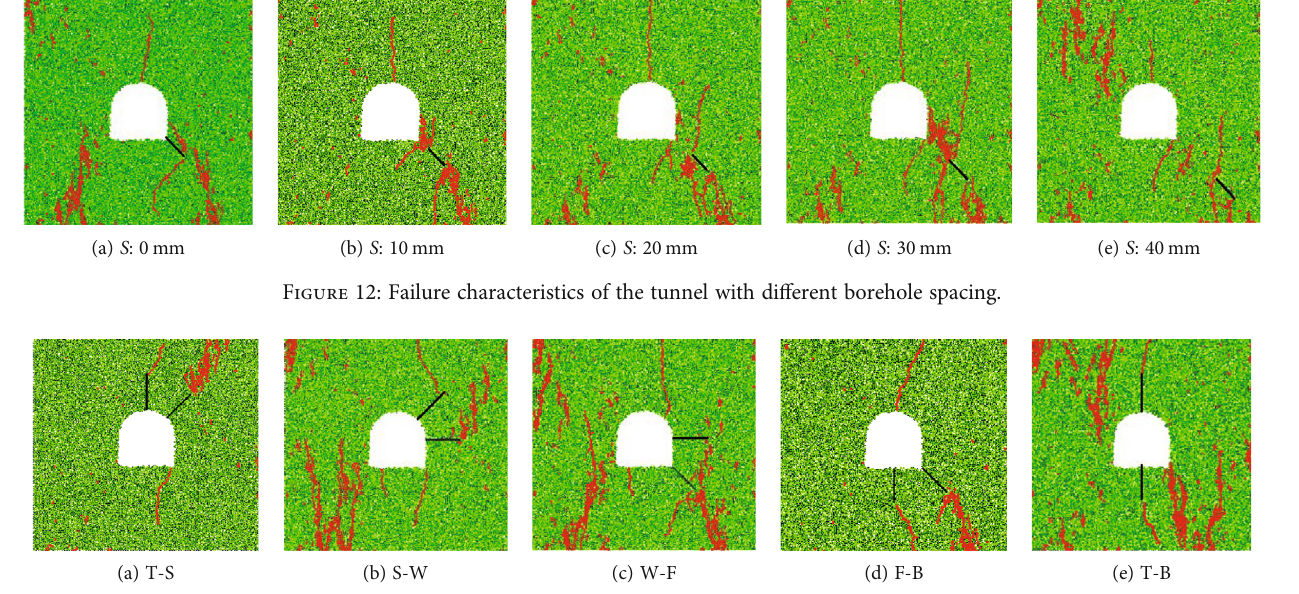
Figure 13: Failure characteristics of the tunnel with di ff erent double-joint